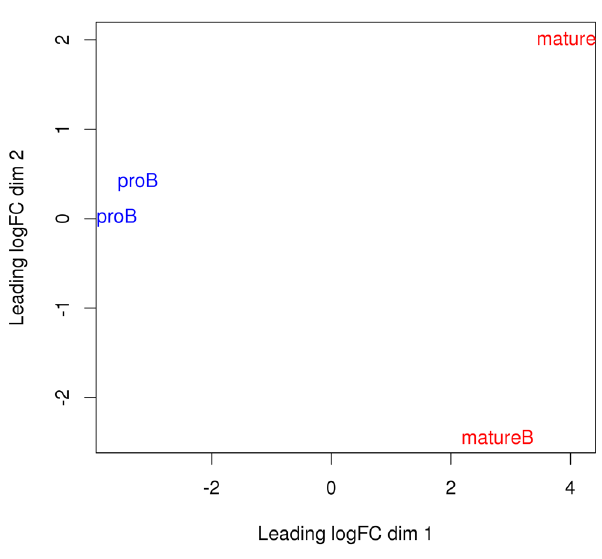
Figure 7. MDS plot with two dimensions for all libraries in the H3K9ac data set. Libraries are labelled and coloured according to the cell